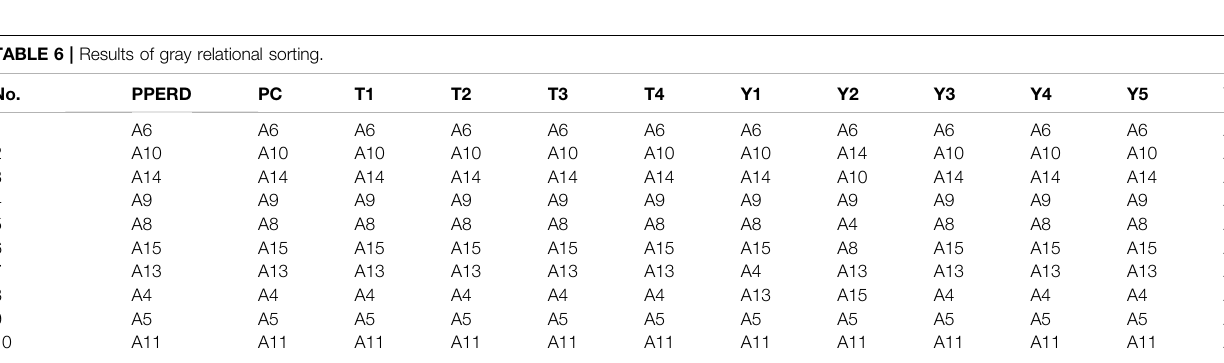
TABLE 6 | Results of gray relational